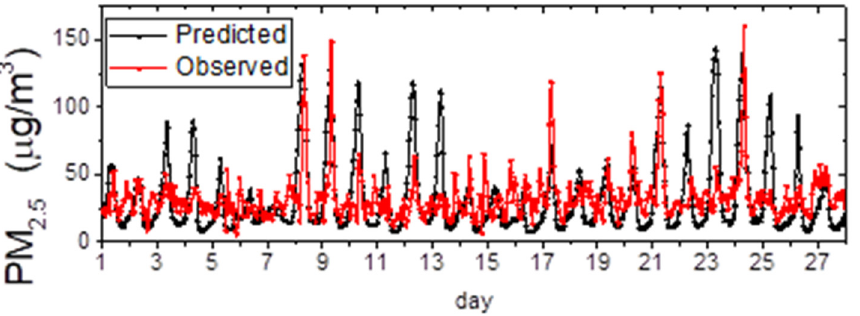
Figure 5. Time series of observed hourly variations in the PM 2.5 concentration for Ate automatic air-quality monitoring stations (AAQMS) in the Metropolitan Area of Lima and Callao (MALC), in comparison to the control case model result (predicted).